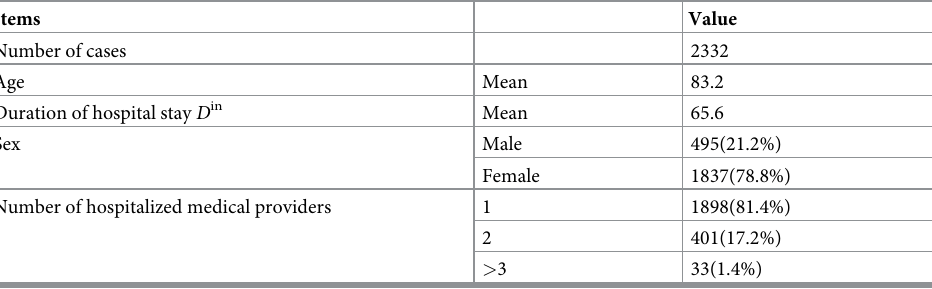
Table 3. Information of targeted